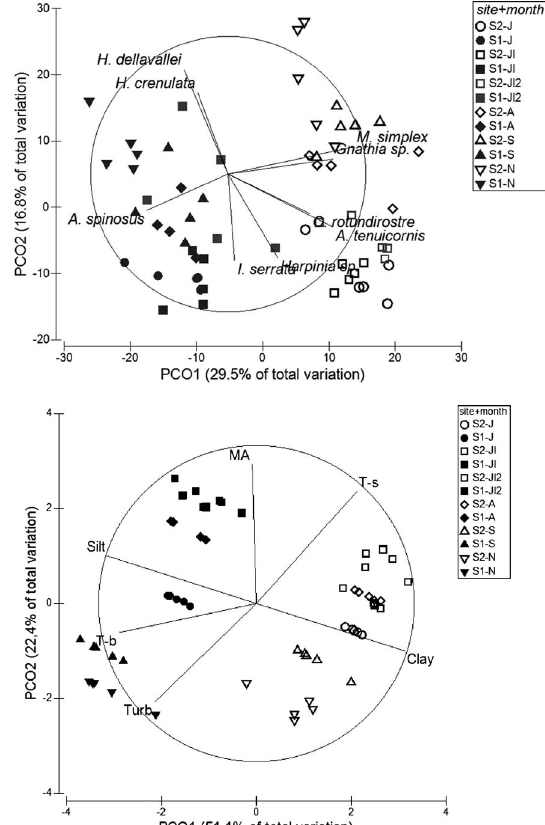
Fig . 6. – PCO plots based on the species abundance (a) and physical data (b) collected from June to November (J, June; Jl, first cruise of July; Jl2, second cruise of July; A, August; S, September; N, November). Vectors included for species/physical variables with Pearson correlation index >0.6. T-b is the near-bottom temperature, T-s is the difference between surface and bottom temperature, Turb is the near-bottom turbidity and MA is the mucilaginous aggregates. Black symbols S1 and open symbols